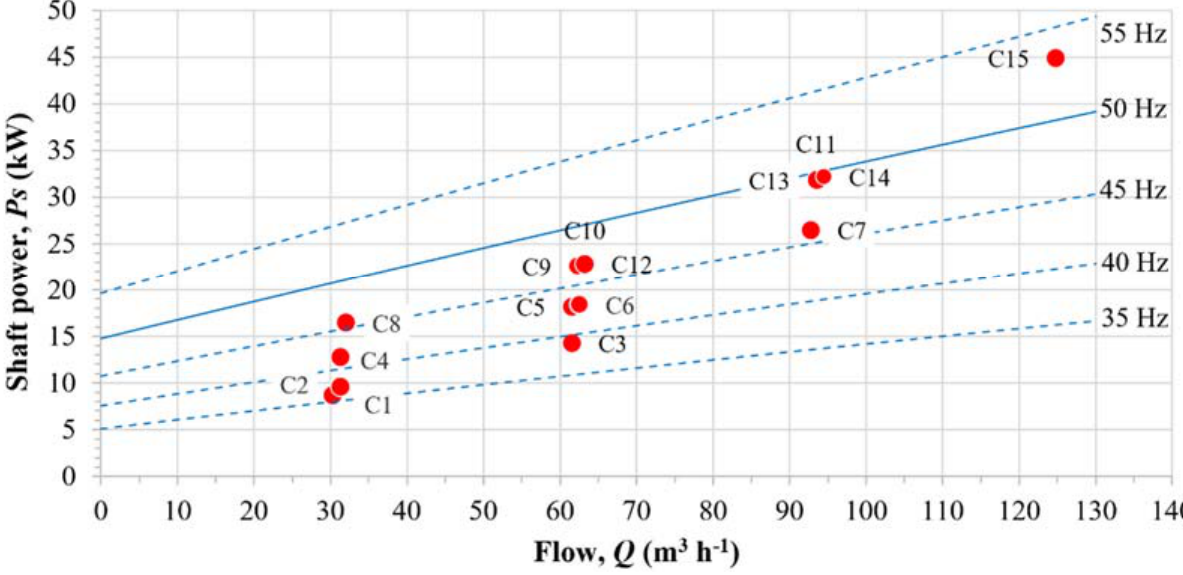
Figure 8. Characteristic curves of the centrifugal pump at different rotational speeds and the 15 operating points corresponding to the minimum values of pressure supplied to the irrigation network for each combination of irrigation sectors C1 to C15 (Table 9).